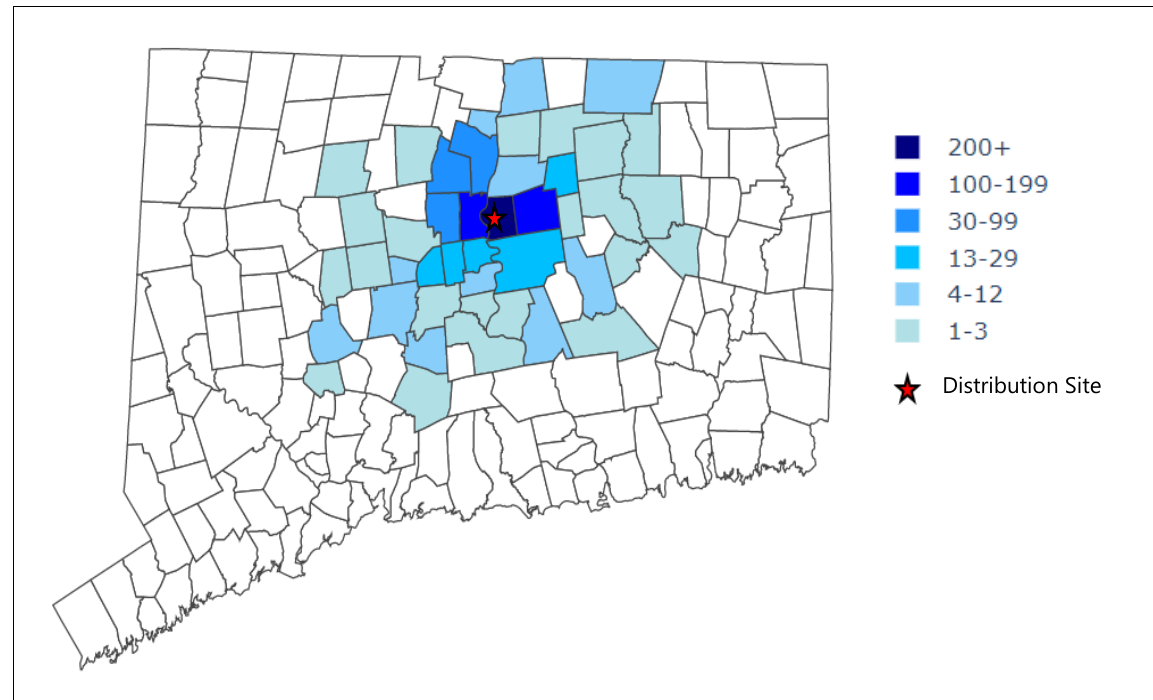
Figure 1. Number of Cars V isiting Foodshare’s Drive -Through Distribution by